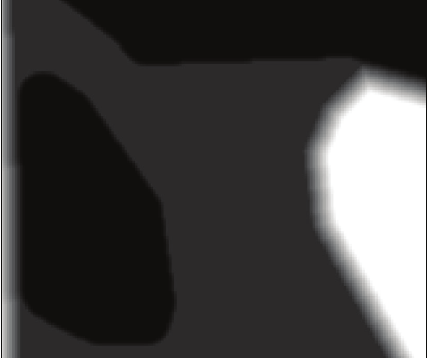
Figure4:Visualizationofcalculationresultsofcoefficient 𝐶 2 -detail.